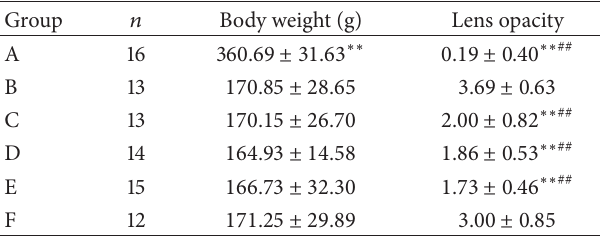
Table 2: The body weight and lens opacity of cataractous rats after four weeks treatment with rHV3 eye drops ( 𝑥 ± 𝑠 ).